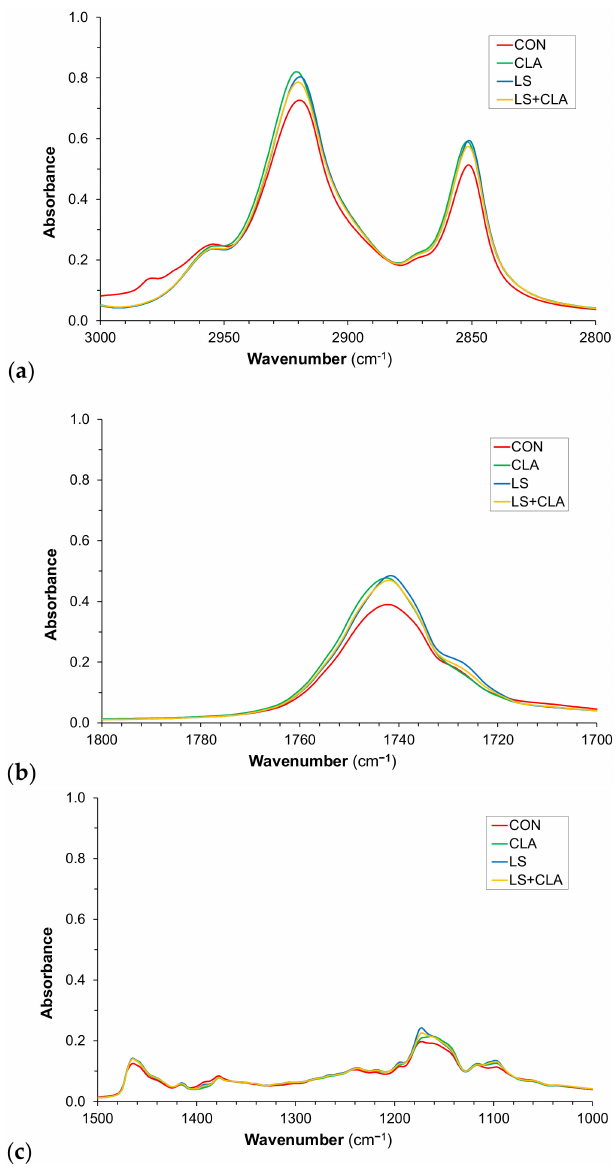
Figure 4. Average fat FTIR-spectra for fat samples according to the four dietary treatments: CON = control, LS = 10% linseed, CLA = 2% conjugated linoleic acid, and LS+CLA. Range selected from 3000 to 2800 cm − 1 ( a ), from 1800 to 1700 cm − 1 ( b ), and from 1500 to 1000 cm − 1 ( c